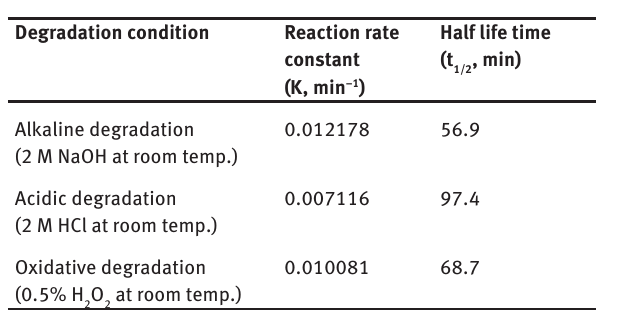
Table 6: Results of the degradation study of SOT (260ng/mL) under different stress conditions on the kinetic parameters of SOT at room temperature